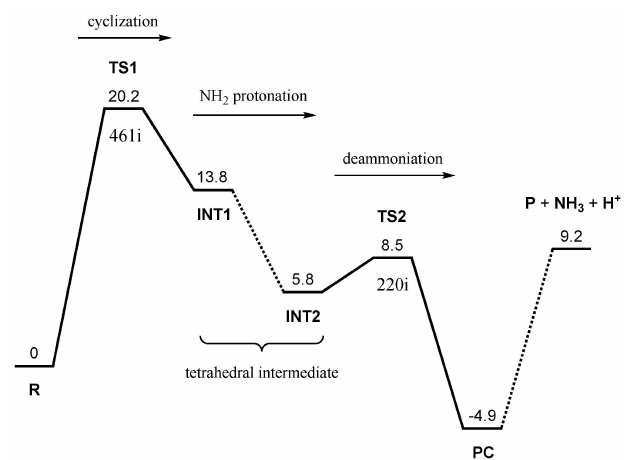
Figure 2. Energy profile for the SI formation from the model compound shown in Figure 1. ZPE- and hydration free energy-corrected relative energies are shown in kcal ¨ mol ´ 1 . R: reactant; TS: transition state; INT: intermediate; P: product; PC: product complex. The imaginary frequency (cm ´ 1 ) is also shown for TS1 and TS2.